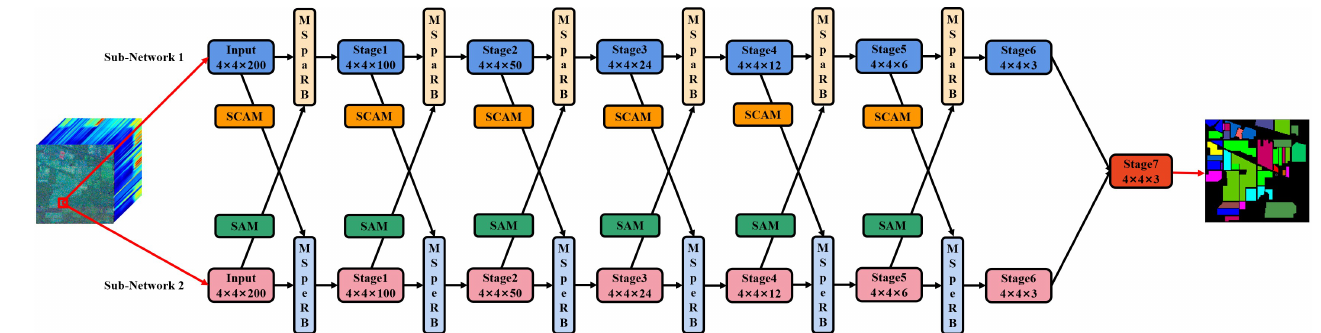
Figure 1. The architecture of the proposed DA-IMRN network. DA-IMRN consists of two branches, and the dual-attention mechanism is used for feature interaction between two branches. MSpaRB represents the multi-scale spatial residual block; MSpeRB represents the multi-scale spectral residual block; SCAM represents the spatial & channel attention module and SAM represents the spectral attention